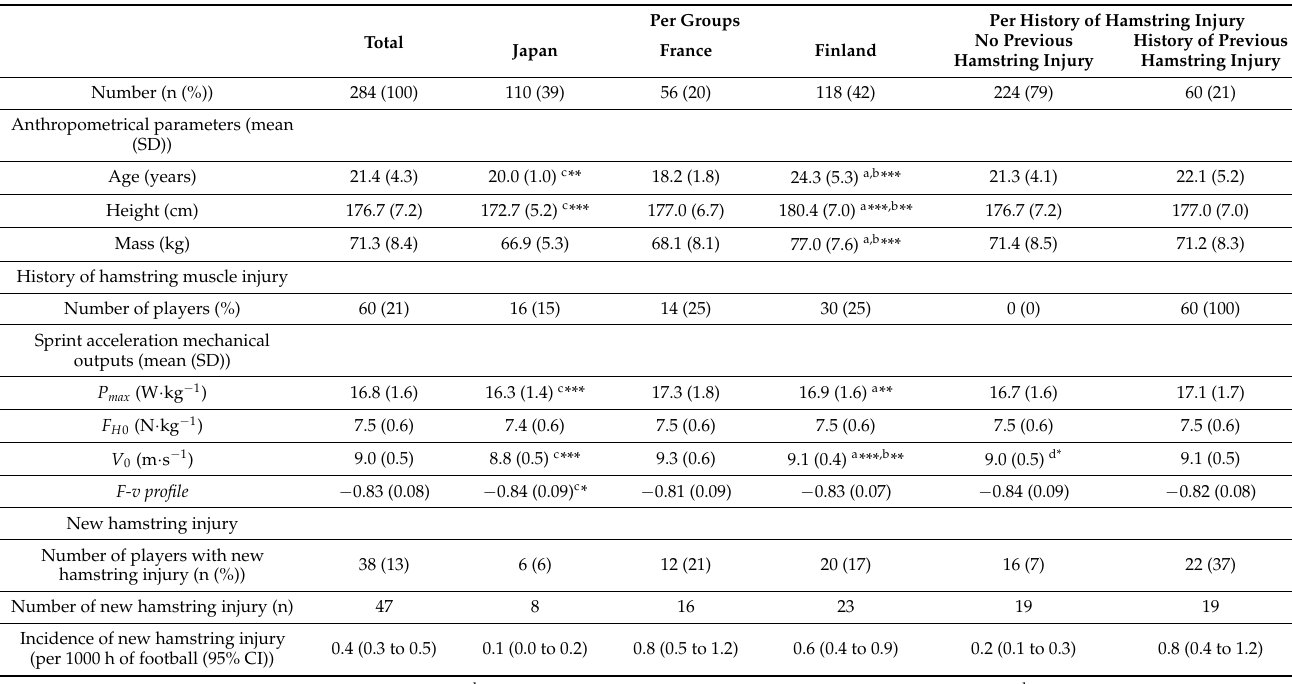
a Finland differed from Japan and from France; b Finland differed from France; c Japan differed from France; d “No previous hamstring injury differed” from “History of previous hamstring injury”; * p < 0.05; ** p < 0.01; *** p < 0.001. 95% CI: 95% confidence interval. F-v profile corresponds to the slope of the F-v linear relationships. Among the 284 included players, a total of 241 injuries (95% leading to time loss in football) were reported during the season in 159 players (56%). The main injury diagnosis was ankle sprain ( n = 52, 22%), followed by three groups (lower for Japan group) and between players with and without history of hamstring injury (higher in players with history of previous hamstring